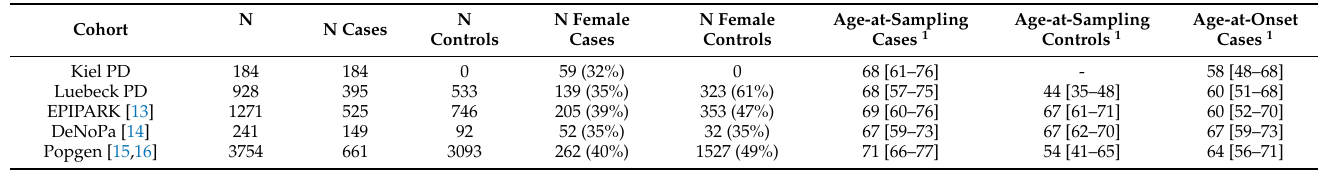
Table A1. Cohorts used in this